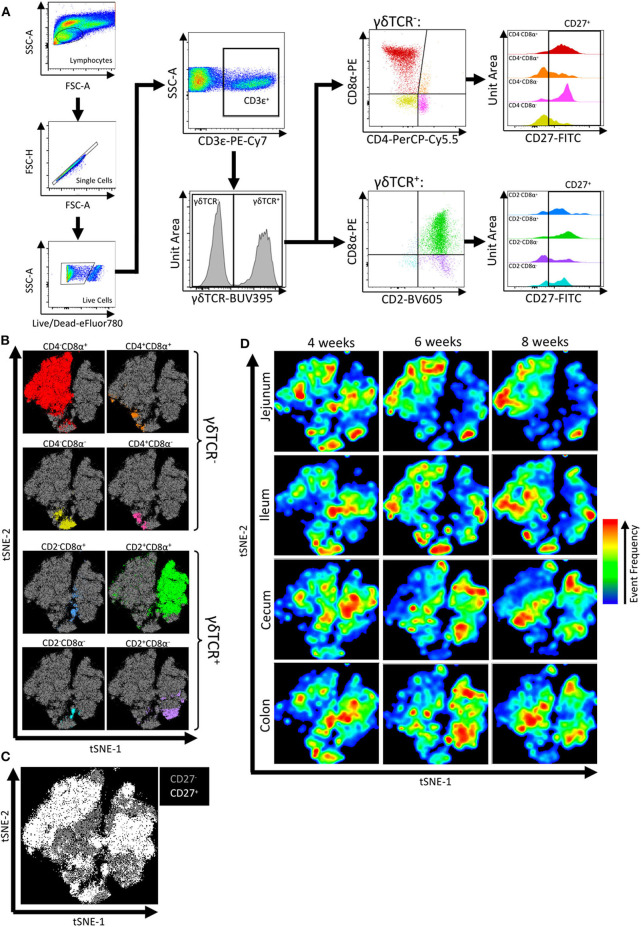
Flow cytometry gating revealed IET populations and CD27 expression varied by intestinal location and age. (A) Gating strategy used to identify IET populations and subpopulations from flow cytometry data of epithelial-enriched samples. (B–D) t-SNE dimensional reduction of gated flow cytometry data from all samples to reveal clustering of αβ and γδ IET populations (B), CD27+ and CD27− expression (C), and tissue and age-specific cell frequency distributions (D). In (B,C), individual points represent single cells. Plot axes indicate t-SNE dimensions. Cells highlighted in non-gray colors coordinate with corresponding αβ and γδ IET populations (B) or CD27+ classification (C). In (D), areas with more cells present are indicated by red, whereas areas with less cells present are indicated by blue. Subsets of total IETs were taken from each sample (n = 990) to obtain equal cell numbers for each individual sample; an equal number of cells are present for each animal and combination of intestinal tissue and timepoint. Samples were taken from four animals per timepoint in each of two separate experiments (n = 8 per timepoint; n = 24 total).